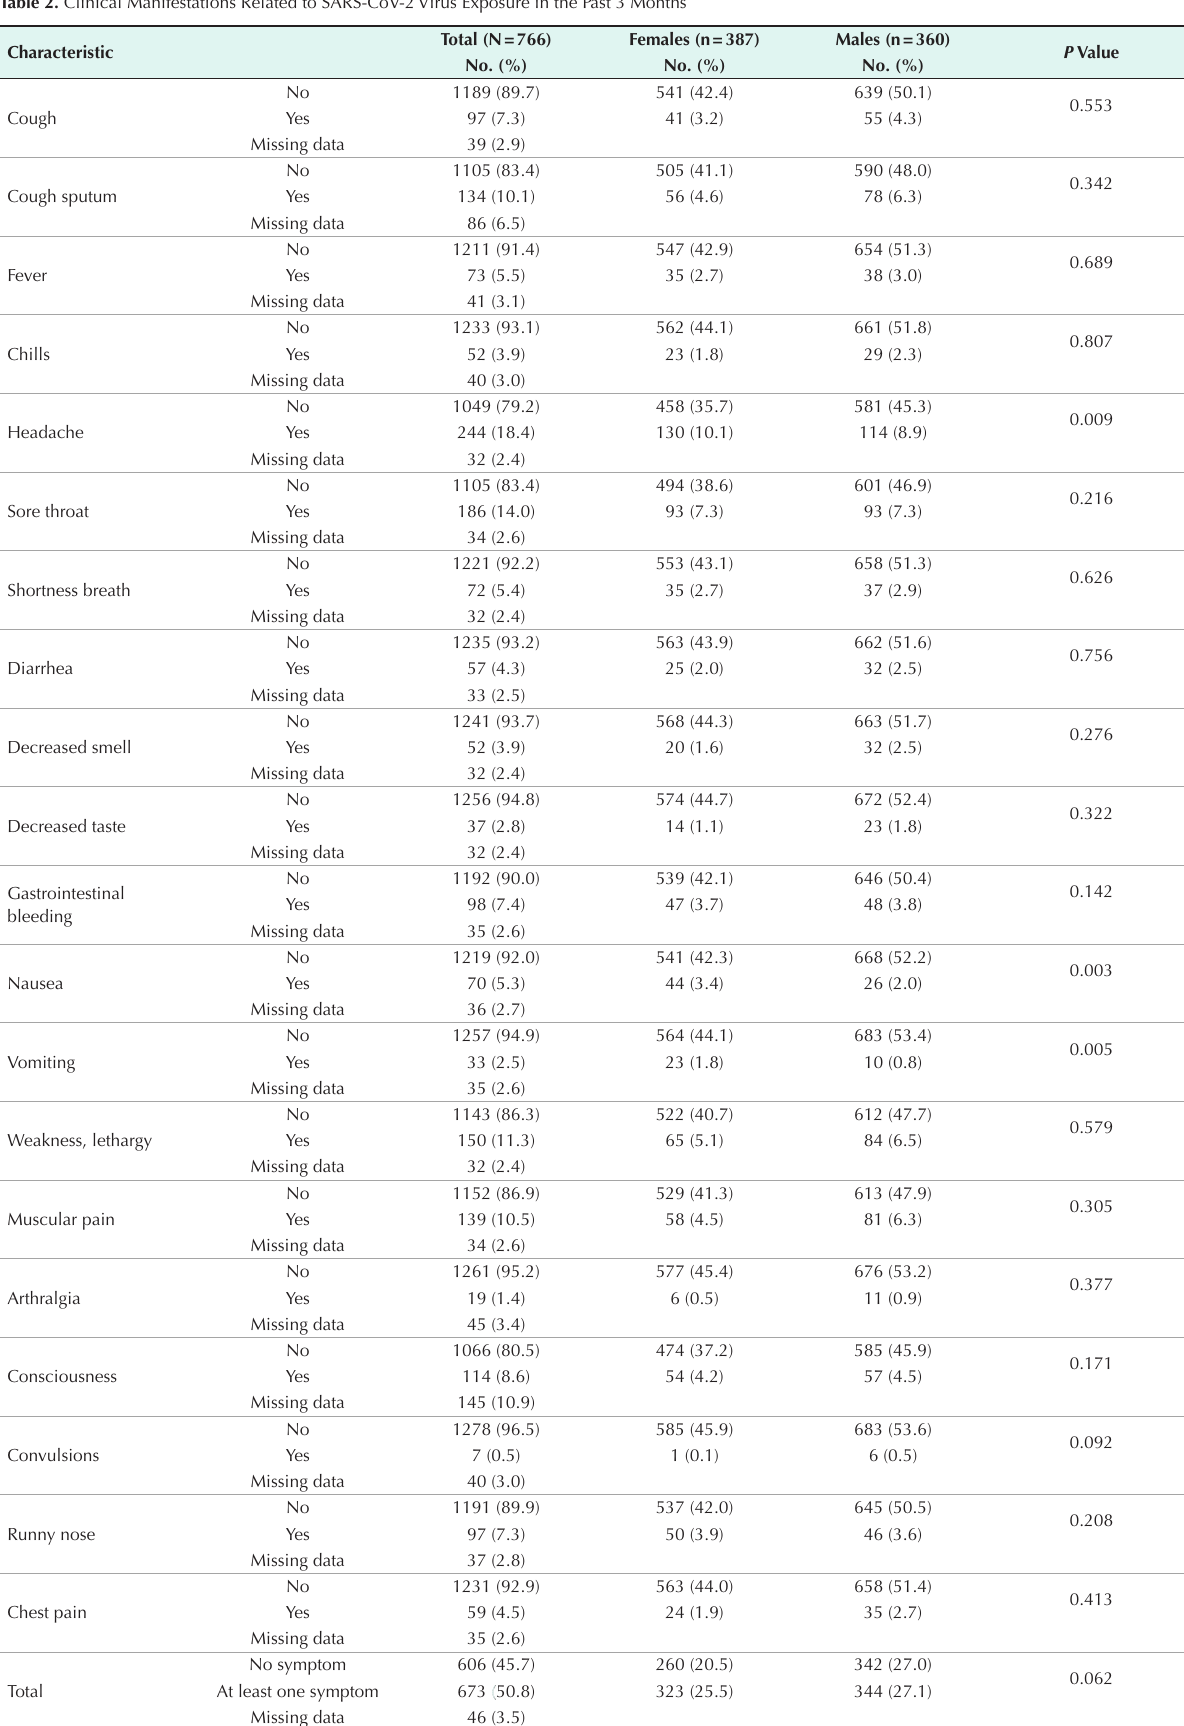
Table 2. Clinical Manifestations Related to SARS-CoV-2 Virus Exposure in the Past 3 Months